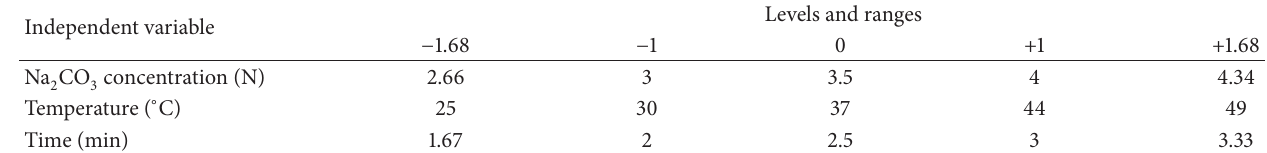
CO concentration, temperature, and time) employed in the first and second 2 3